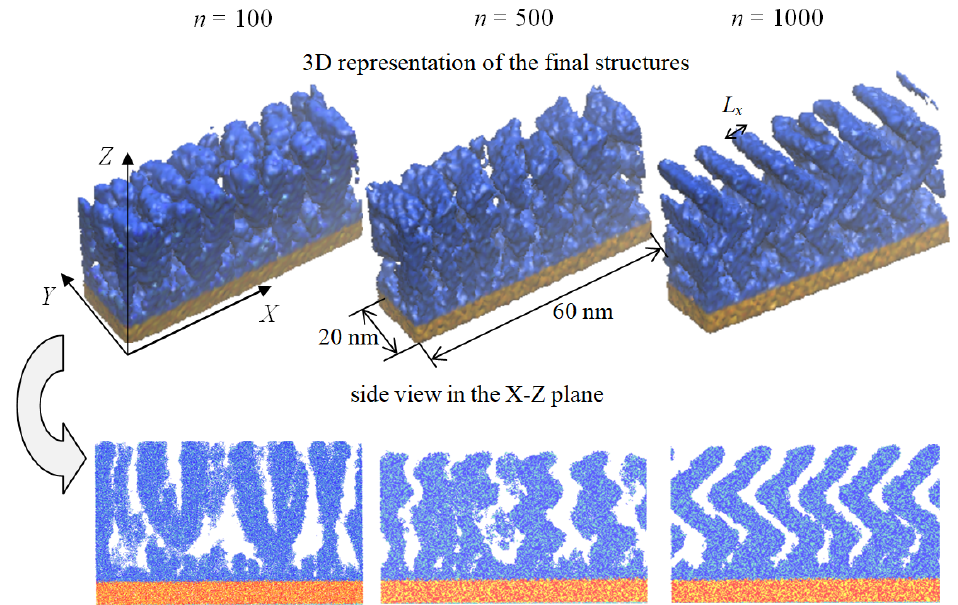
Figure 3. 3D representation of the final GLAD structures deposited on large substrates and side views in the X-Z plane. Other designations are the same as in Figure